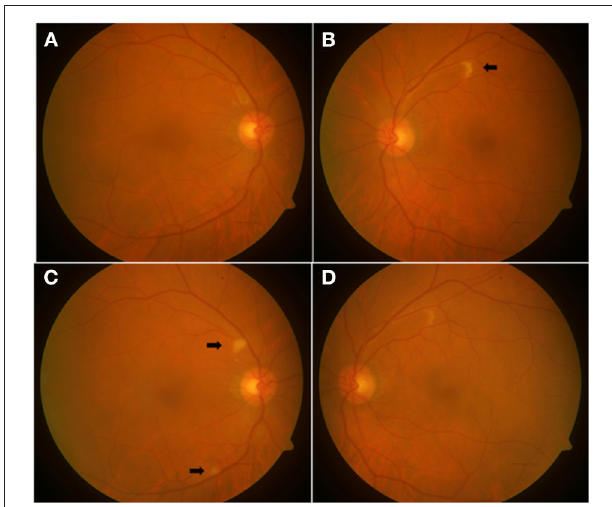
FIGURE 2 | Color fundus photographs of a 73-year-old male patient in convalescent phase, examined after 44 days of COVID-19 diagnosis, showing a normal fundus of the right eye (A) at the first examination visit, with a CWSs in the left eye (B) . Two weeks later, two new CWSs (arrows) appeared in the right eye (C) , and the left eye showed the resolving CWSs (D) .